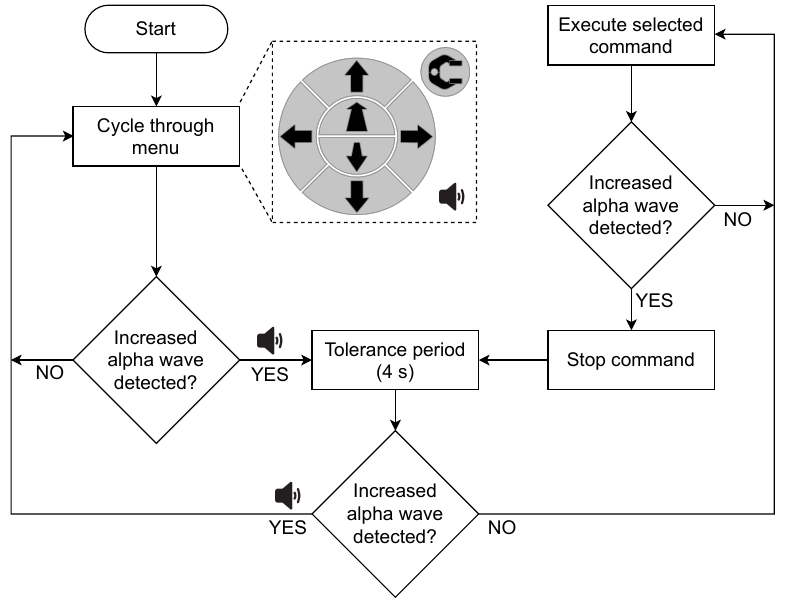
Figure 2. Control Loop Schematic. The user selects a target command from the cyclic menu. Com- mands are presented in the following sequence: up, down, left, right, front, back, and grip. The robot executes said command (except for “grip”) until a stop order is issued by the user.